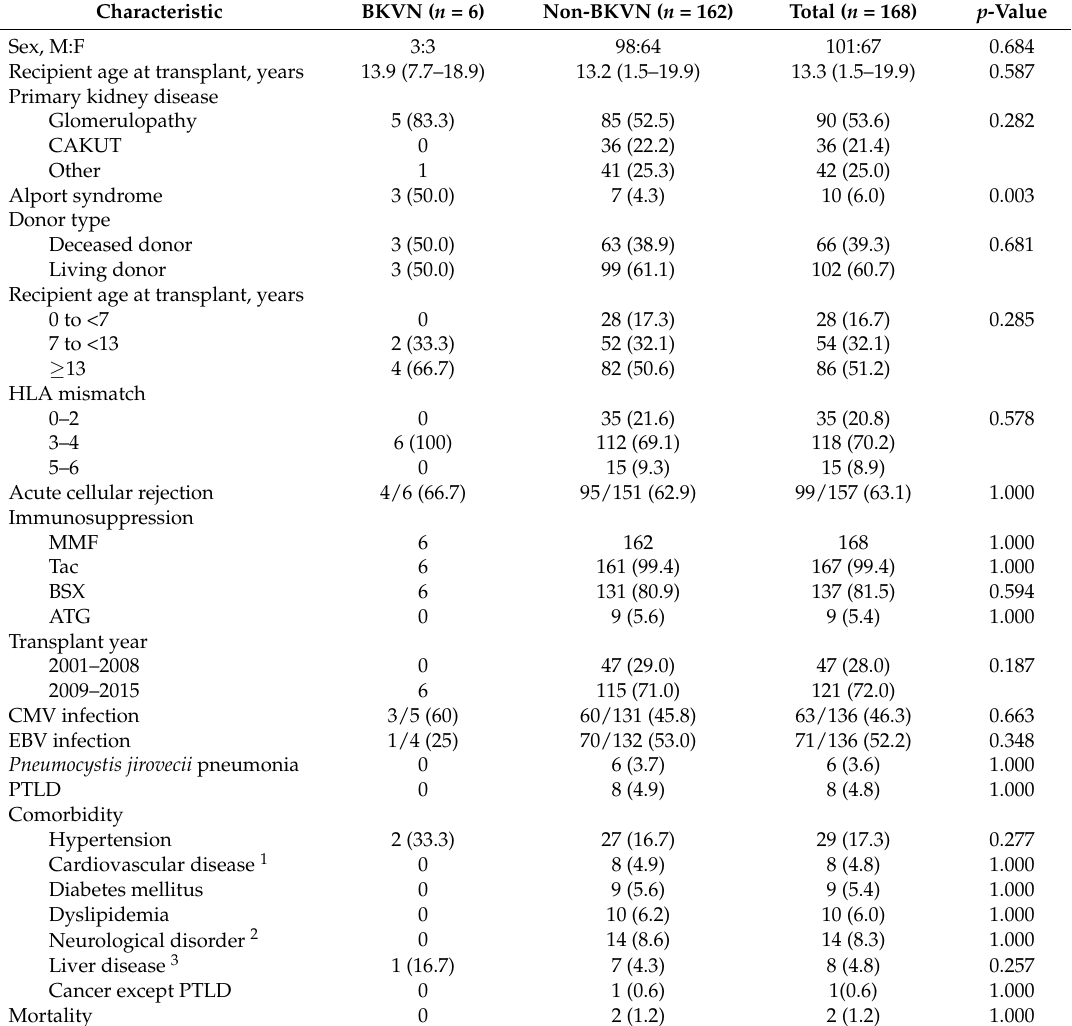
Table 1. Baseline characteristics of patients with or without BK virus